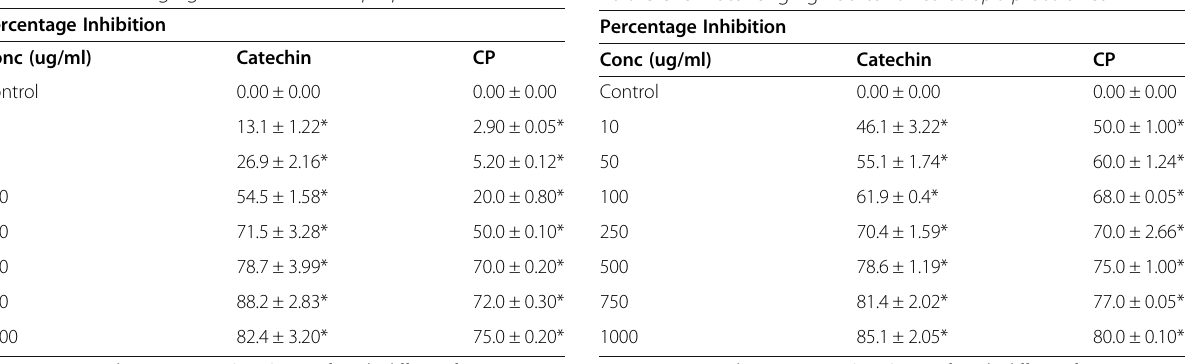
Table 2 NO scavenging Radical of Calotropis procera leaf Table 3 OH scavenging Radical of Calotropis procera leaf